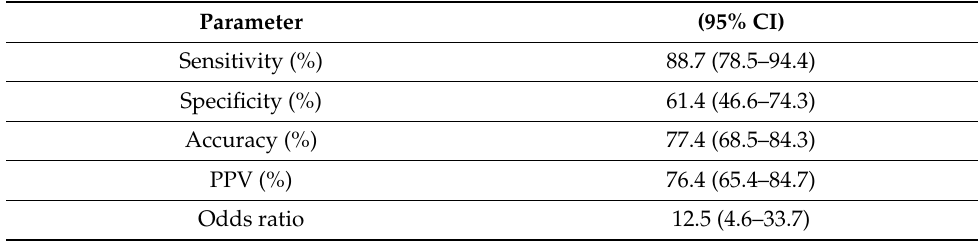
Table 3. Prediction effect of the